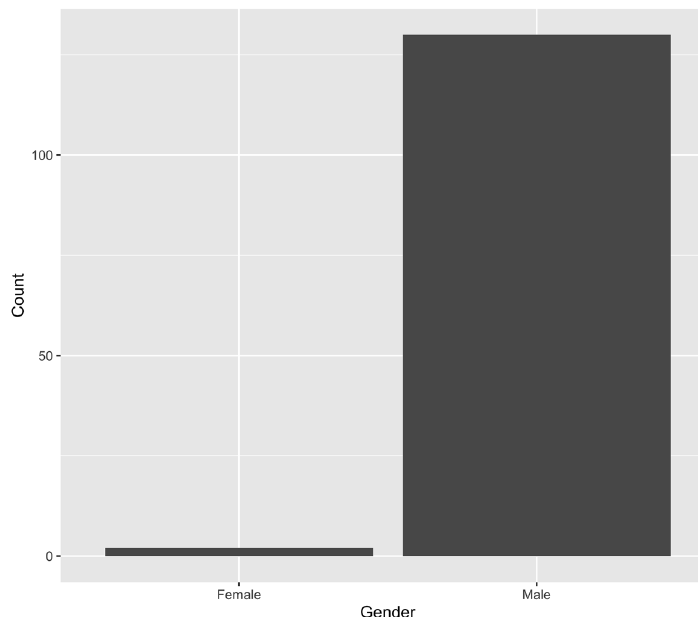
Figure 1. Sex distribution of participants